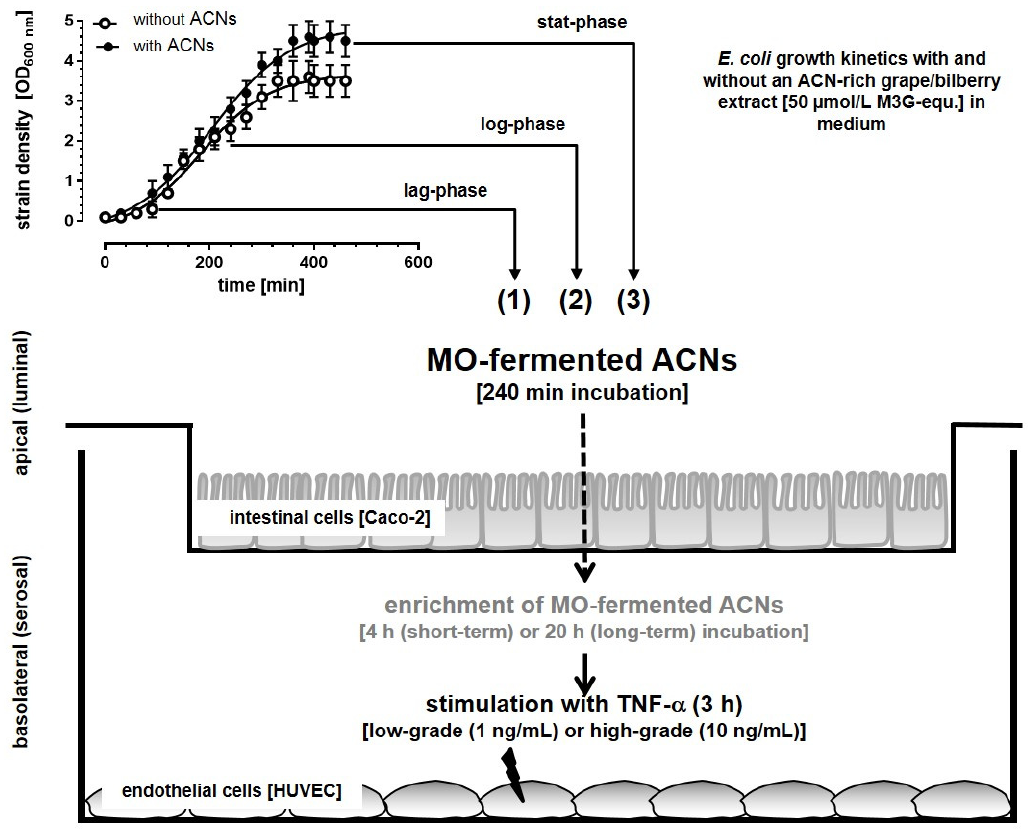
Figure 1. Determination of the anti ‐ inflammatory effects of microorganism (MO) ‐ fermented ACNs their metabolites from lag- (1), log- (2) and stat-phase (3) in an in vitro epithelial-endothelial co-culture and their metabolites from lag ‐ (1), log ‐ (2) and stat ‐ phase (3) in an in vitro epithelial ‐ endothelial cell system by using, e.g., E. coli co ‐ culture cell system by using, e.g., E. coli supernatants.